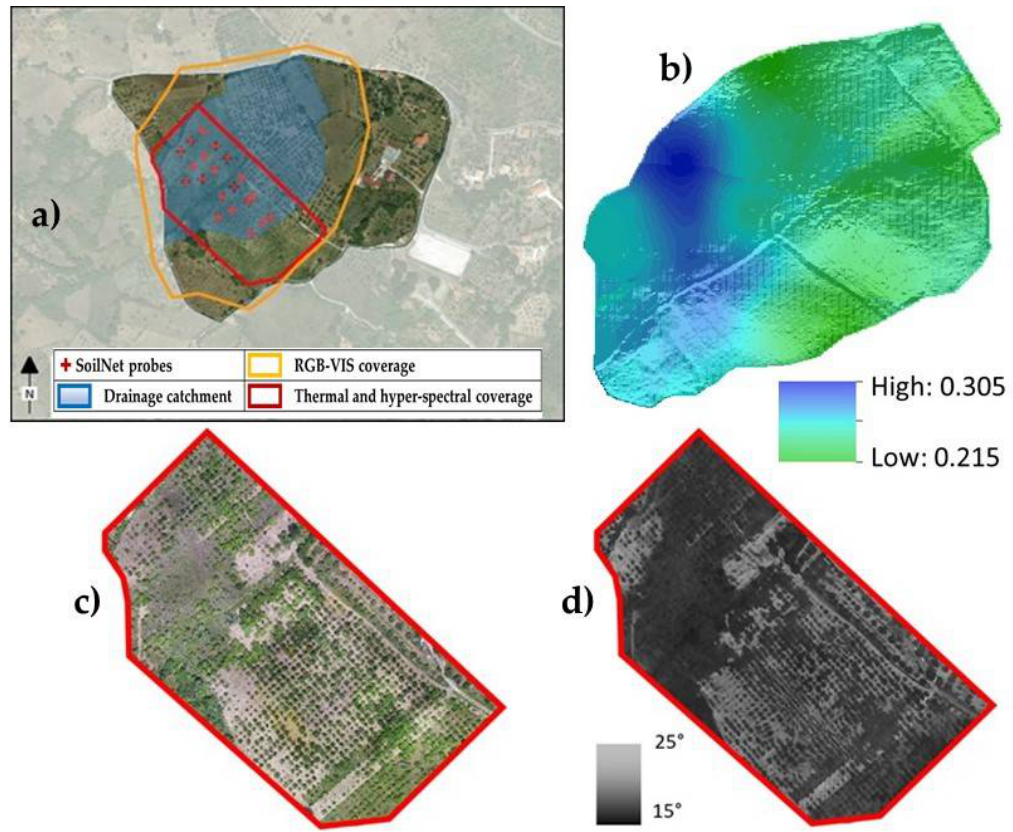
Figure 7. ( a ) Overview of the MFC2 study area: the shaded light-blue area delimits the MFC2 drainage sub-catchment, the red crosses are the locations where soil moisture value is measured by time domain reflectometry (TDR) probes, the red polygon delimits the unmanned aerial system (UAS) footprint for RGB, hyper-spectral, and thermal imagery. ( b ) Near-surface soil moisture map. ( c,d ) RGB and thermal ortho-mosaic imagery, respectively, obtained with the UAS. The field campaign was performed on 4 October 2018.